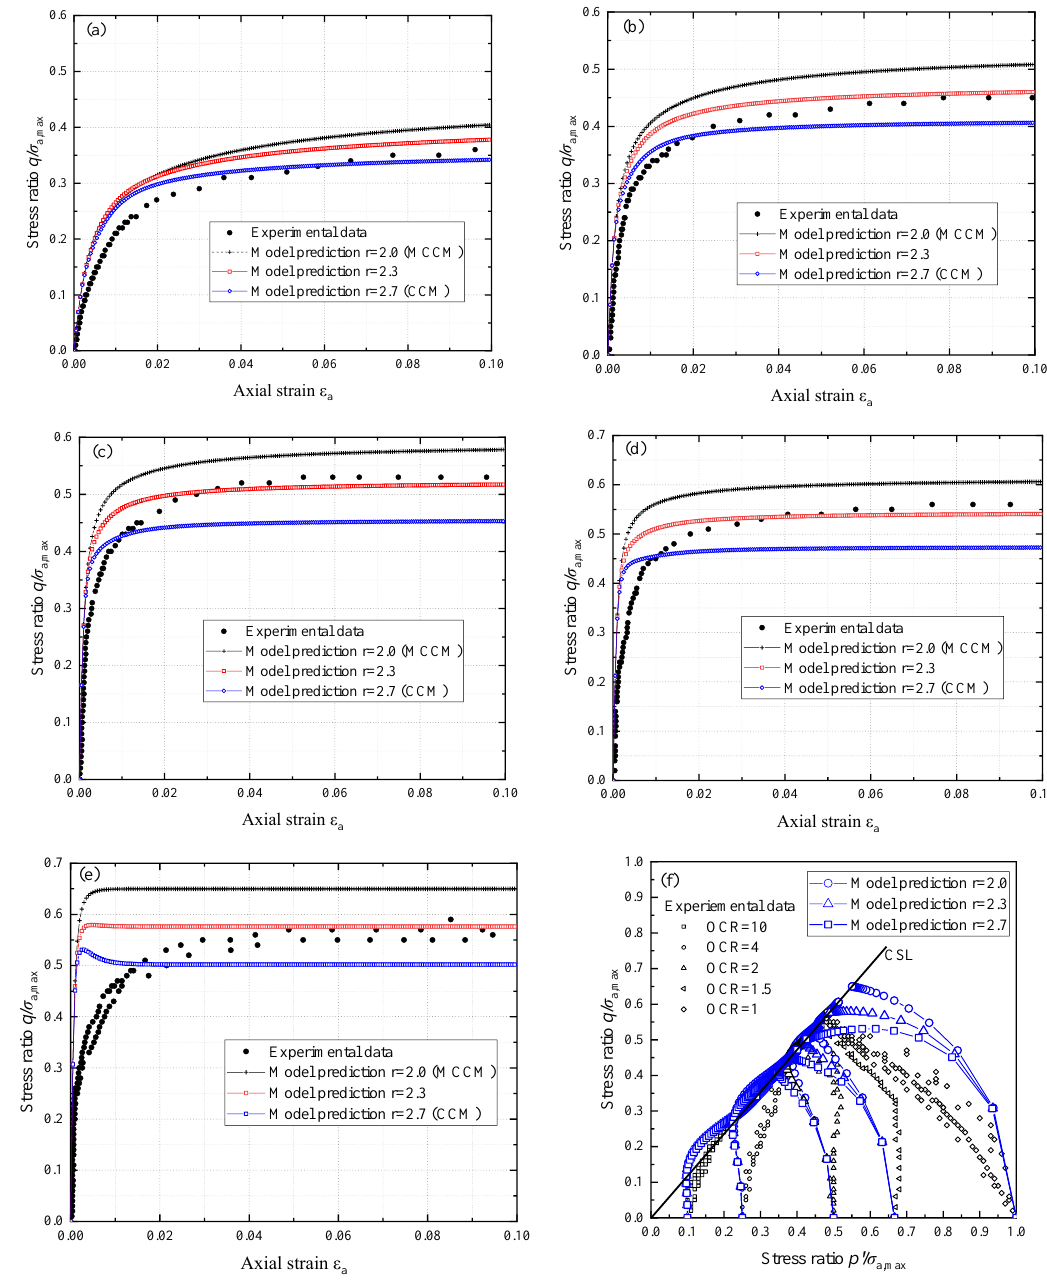
Figure 9. Comparisons between model prediction and test results ( a ) OCR = 10, ( b ) OCR = 4, ( c ) OCR